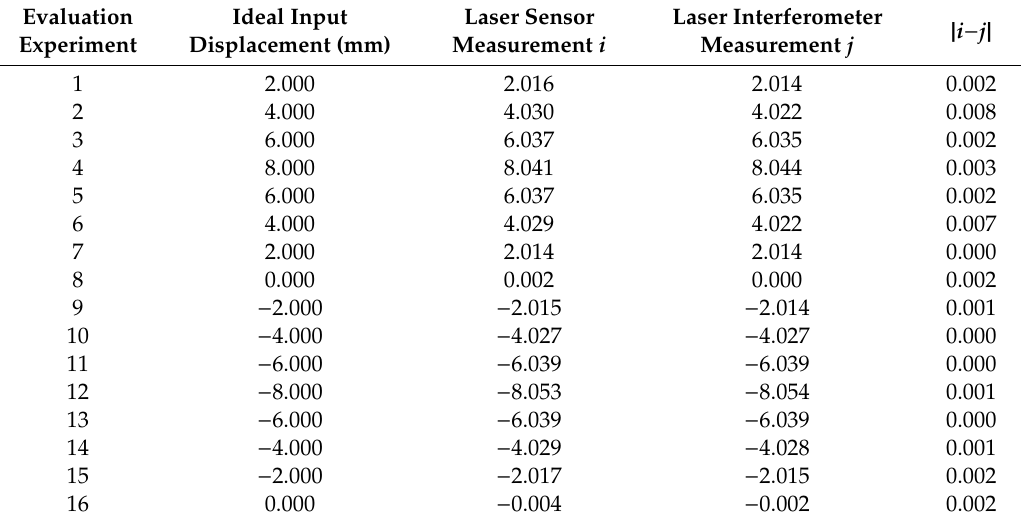
Table 1. Measurement evaluation between the laser sensor and laser interferometer.